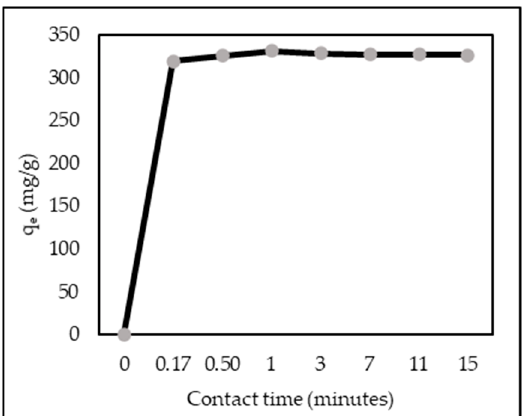
Figure 6. Effect of contact time (ZL–CH hydrogel 30 mg, 100 mg/L AR88 (volume = 100 mL), pH 2.0).